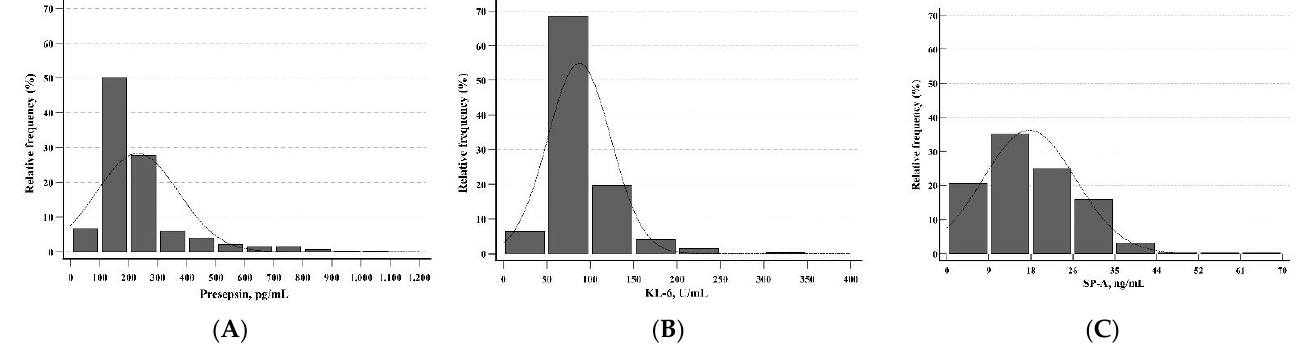
Figure 1. Distributions of presepsin, KL-6, and SP-A in UCB ( n = 613). The distributions of ( A )